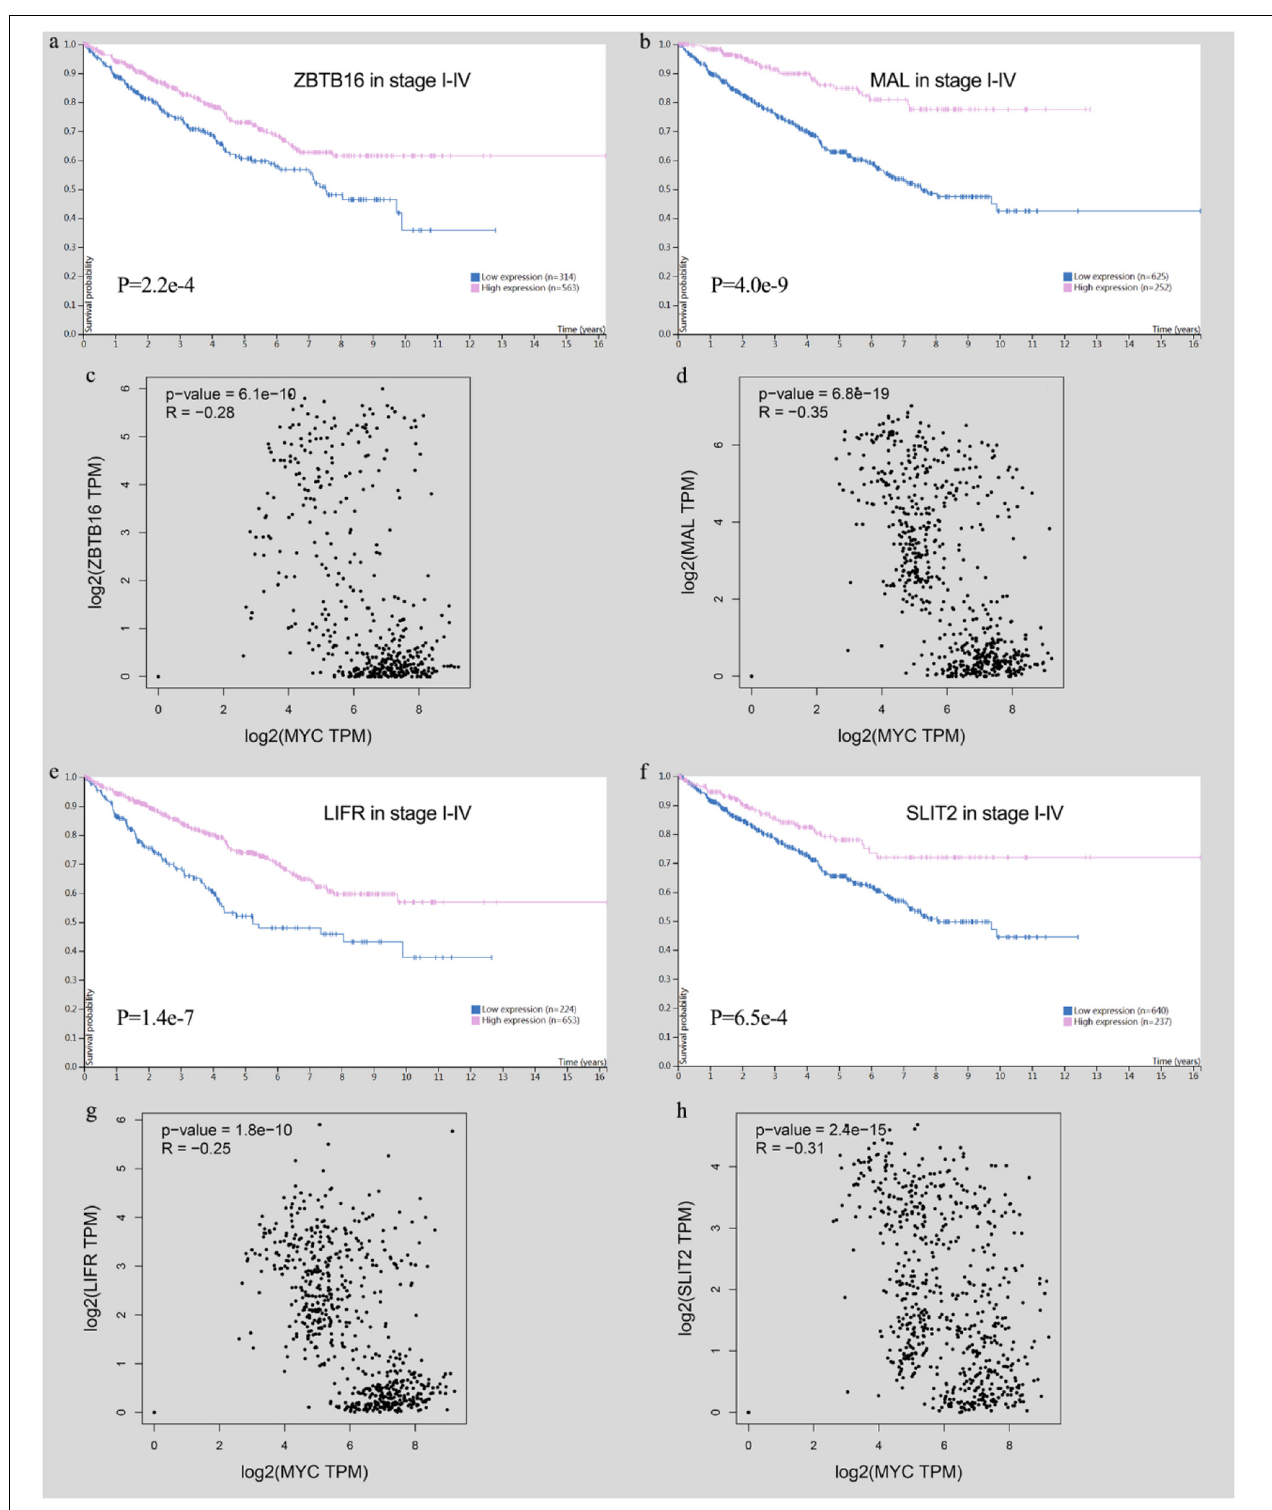
FIGURE 13 | Survival analysis of tumor suppressor genes and the relationship with MYC). (A) ZBTB16 expression was correlated with high survival probability. (B) MAL expression was correlated with high survival probability. (C) ZBTB16 was negatively correlated with MYC. (D) MAL was negatively correlated with MYC. (E) LIFR expression was correlated with high survival probability. (F) SLIT2 expression was correlated with high survival probability. (G) LIFR was negatively correlated with MYC. (H) SLIT2 was negatively correlated with MYC.